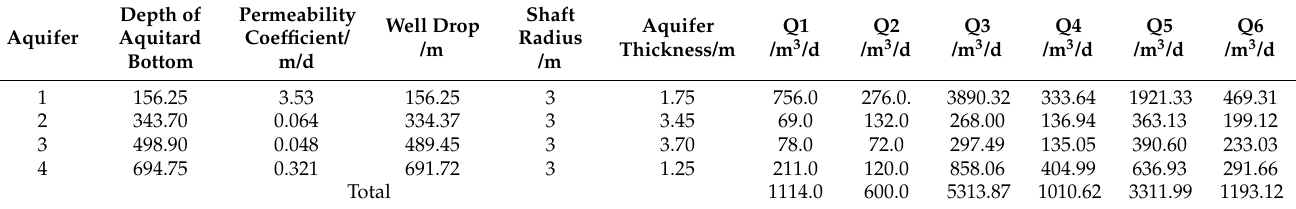
Table 5. Permeability coefficient values for different aquifers with grouting of No. 1 Shaft.